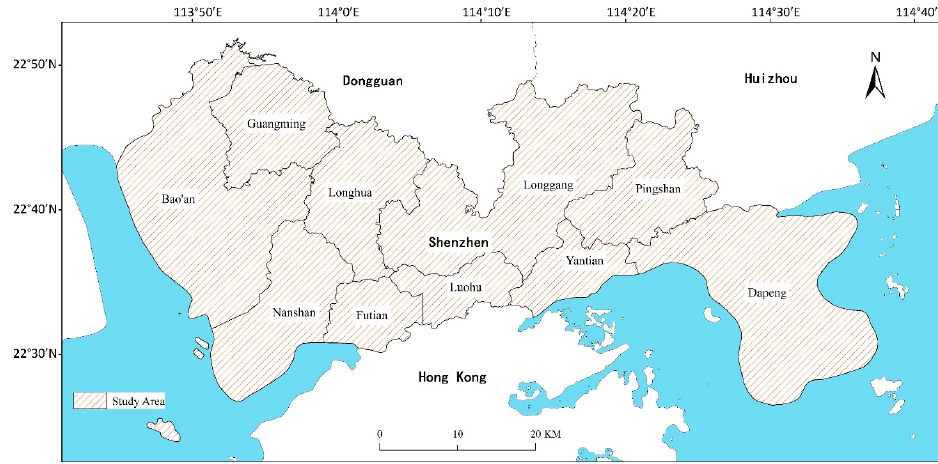
Figure 1. Location of case study area: Shenzhen, China.